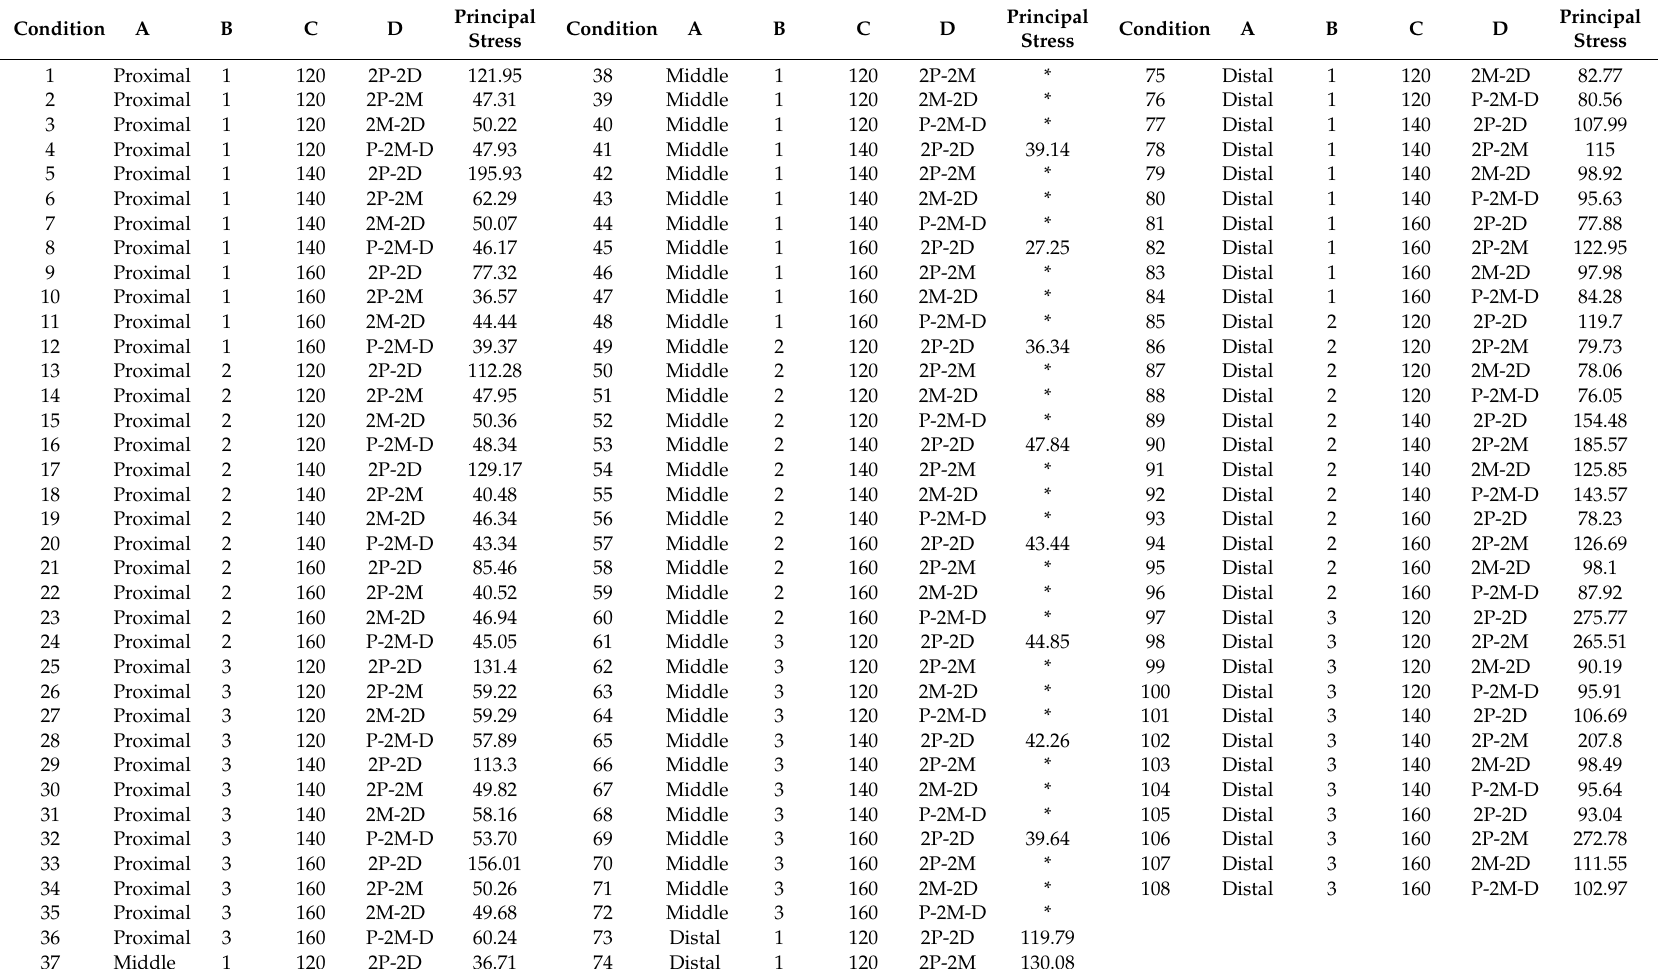
Table 9. FEA model of the four locking screws’ results for the testing